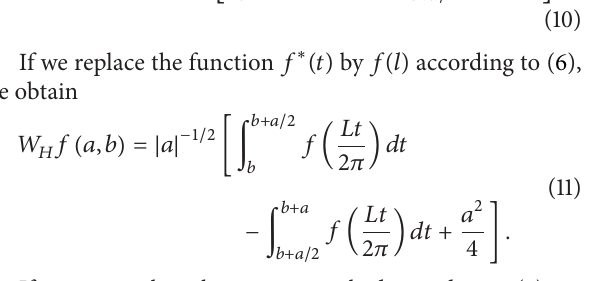
Figure 4: Wavelet building set based on Haar function.